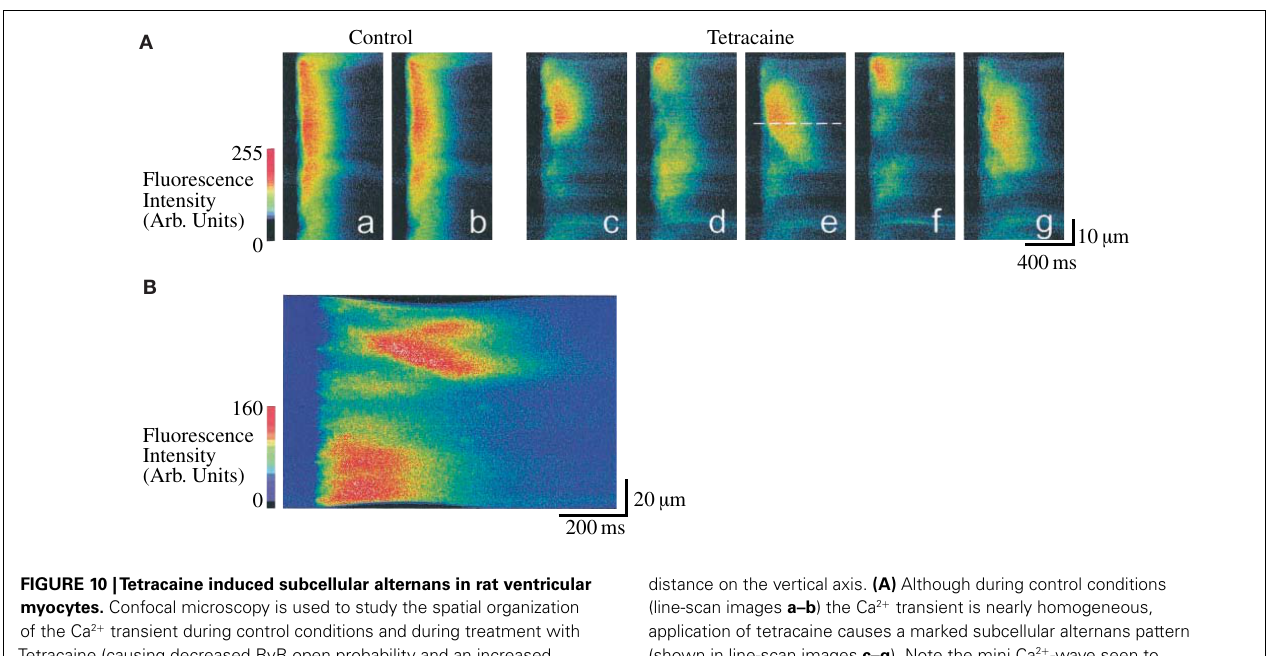
FIGURE 10 |Tetracaine induced subcellular alternans in rat ventricular myocytes. Confocal microscopy is used to study the spatial organization of the Ca 2 + transient during control conditions and during treatment with Tetracaine (causing decreased RyR open probability and an increased subcellular heterogeneity in Ca 2 + release).The line-scan images shown correspond to the relative Ca 2 + concentrations along a single line parallel to the long axis of the cell, plotted with time on the horizontal axis and